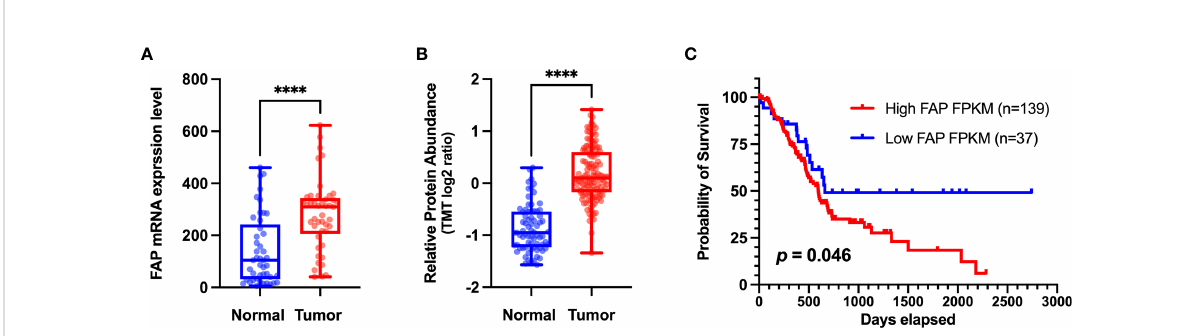
FIGURE 2 (A) Different levels of FAP mRNA expression in normal and tumor tissues. Transcriptome data of pancreatic adenocarcinoma (PAAD) and matched normal tissue were obtained from the Gene Expression Omnibus dataset (http://www.ncbi.nlm.nih.gov/geo) (GSE28735) for